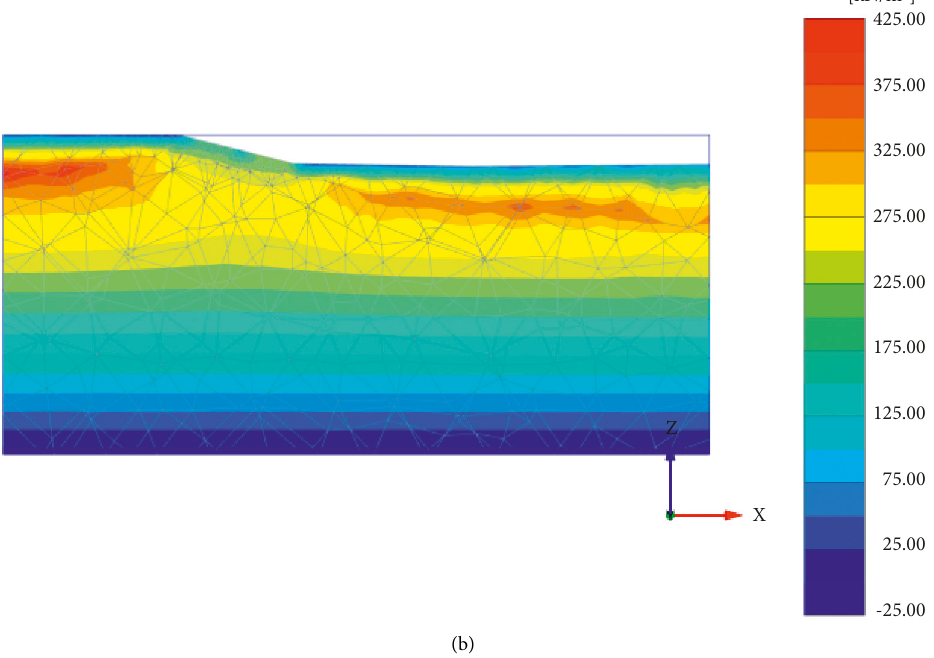
Figure 11: Cloud map of pore water pressure of slope drainage ditch.